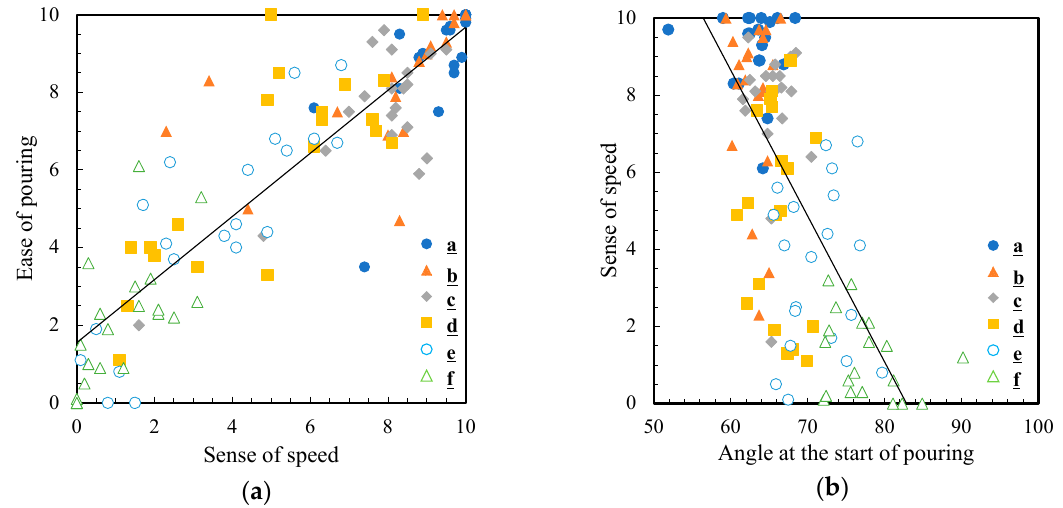
Figure 9. Correlation diagram between ( a ) the ease of pouring and sense of speed and ( b ) sense of speed and angle at the start of pouring. The black line is the approximate straight line.